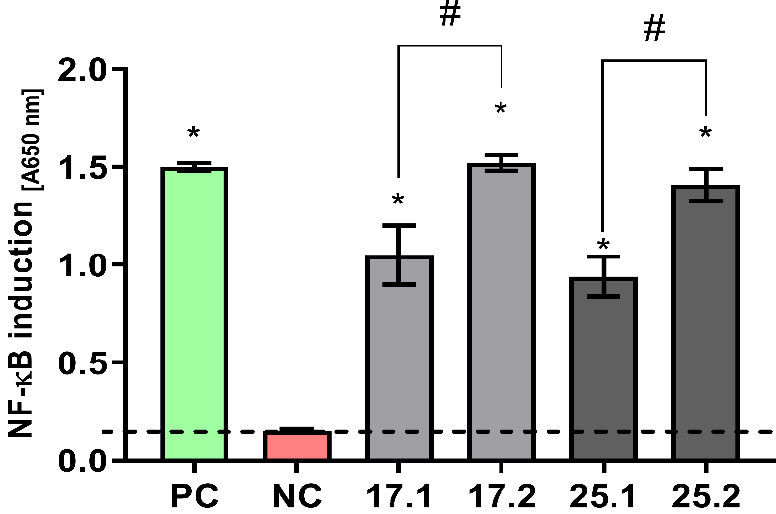
Figure 11. NF- κ B induction in THP1-Blue monocytes incubated for 24 h with biocomposites. The negative control (NC) of the monocyte’s activation (cut-off line) consisted of cells incubated without composites. The positive control (PC) of the monocyte’s activation consisted of monocytes stimulated with PMA (100 ng/mL). The data are presented as the mean ± SD, n = 6. The dashed line indicates the physiological level (0.151 ± 0.008) of the nonstimulated monocytes. * p values (<0.05) calculated in comparison to the untreated cell cultures. #—statistical significance between biocomposites enriched with polyphenols extracted from common sage and their reference (17.1 vs. 17.2 and 25.1 vs. 25.2).